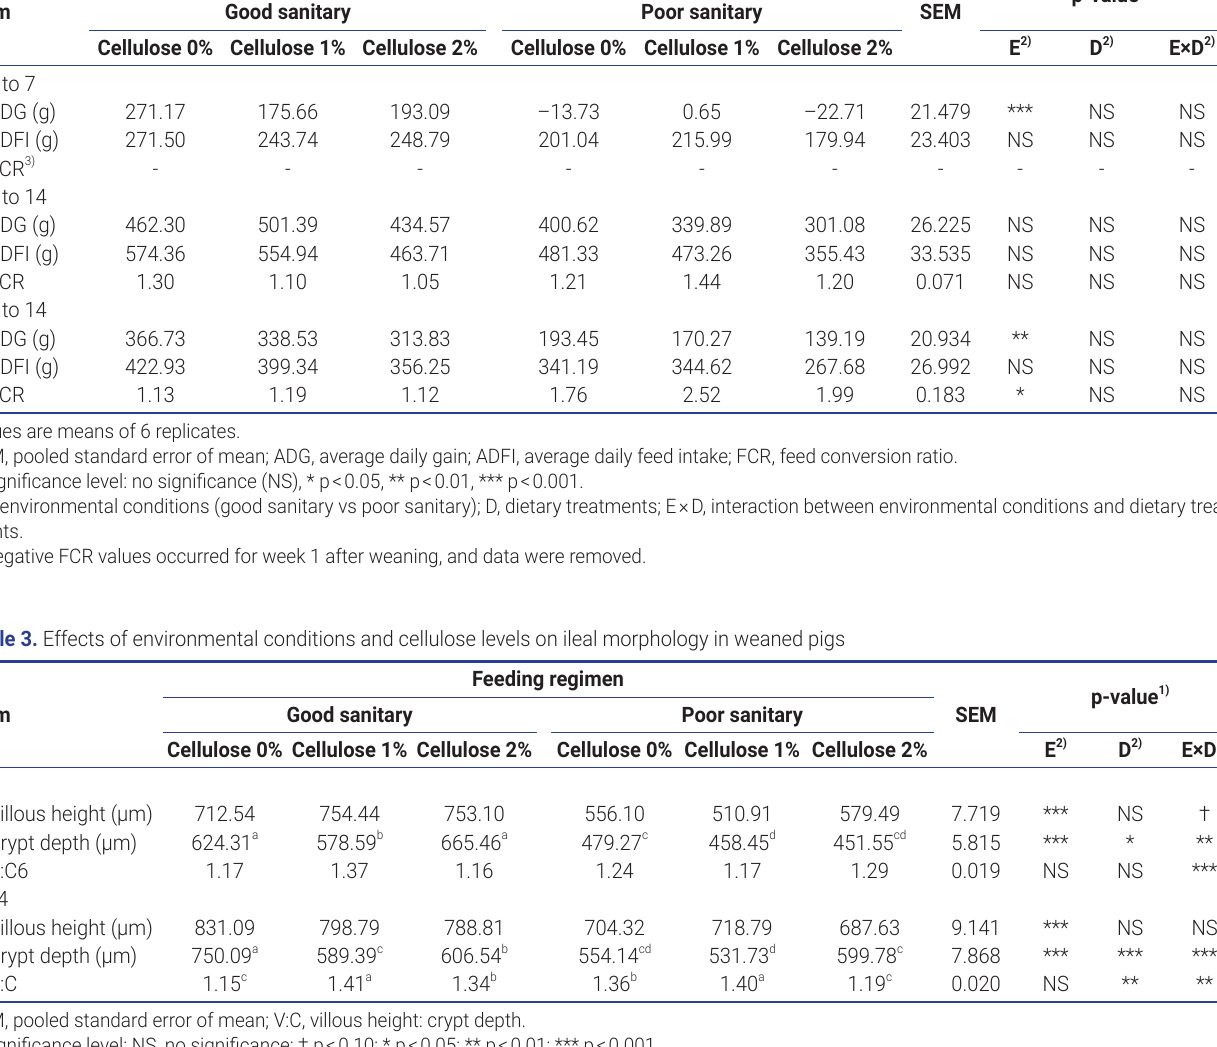
Table 2. Effects of environmental conditions and cellulose levels on growth performance in weaned pigs Item